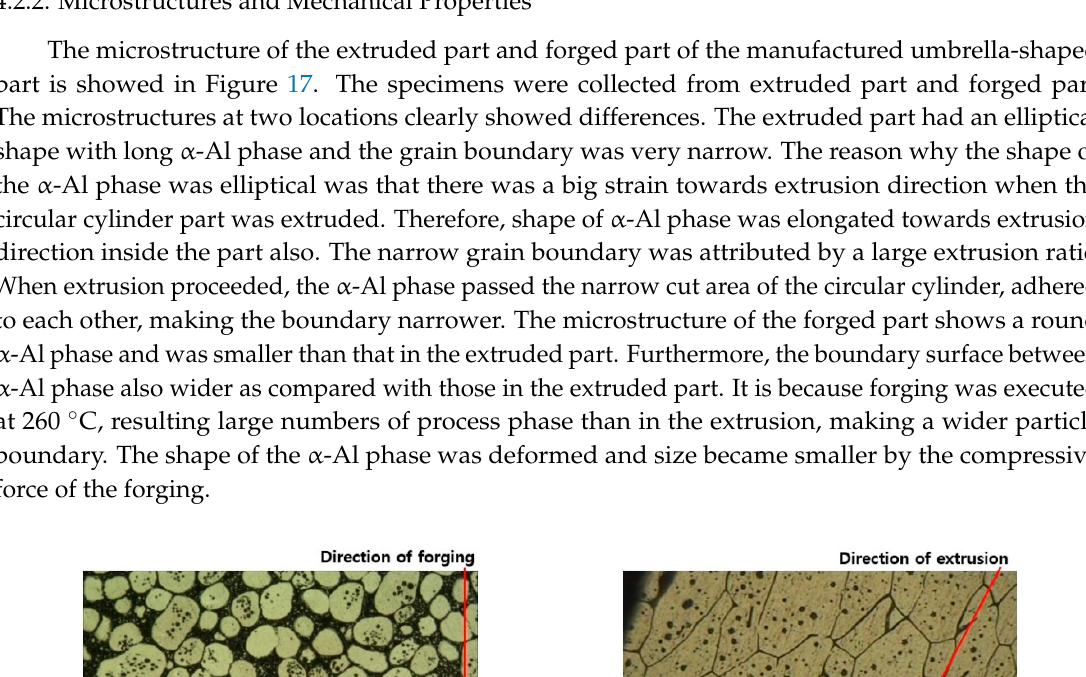
Figure 16. Experiment result of warm forging (produced final part).